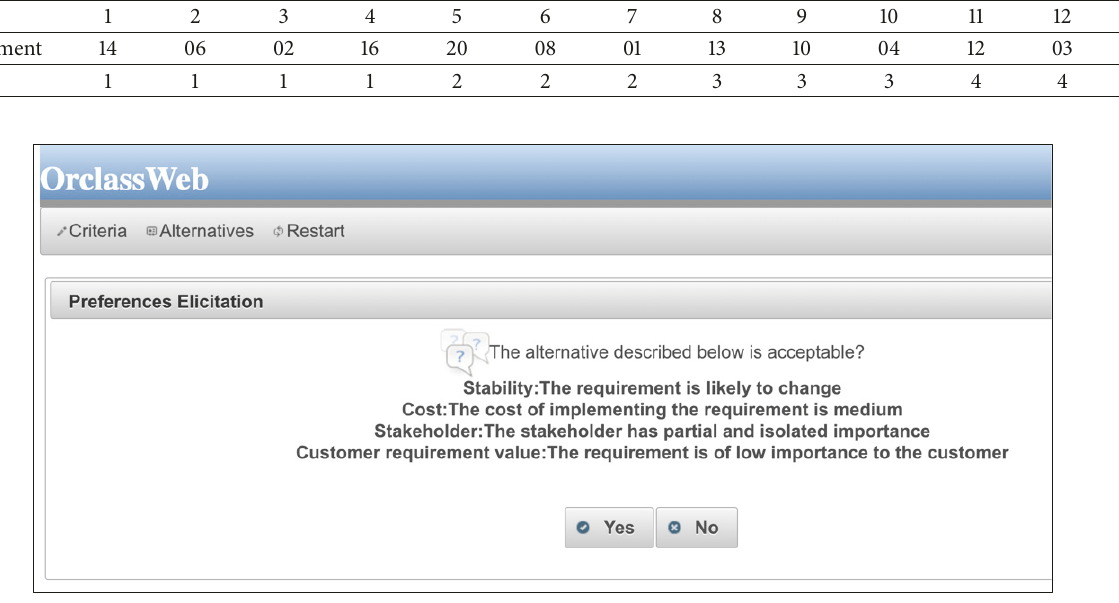
Figure 8: OrclassWeb